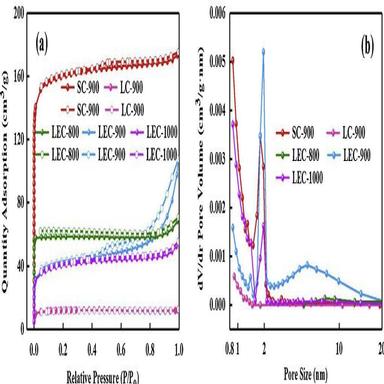
(a) Nitrogen sorption isotherms and (b) pore size distributions of the SC-900, LC-900, LEC-800, LEC-900 and LEC-1000 samples.